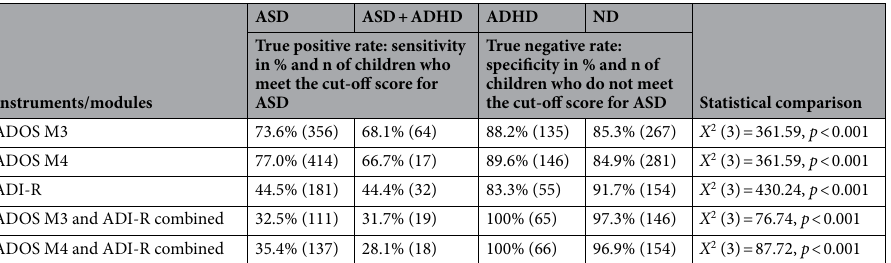
Table 1. Distribution of individuals per group that met total cut-off scores for ASD on the ADOS and/or ADI-R. The table depicts the obtained true positive rates as well as the true negative rates of the four groups with respect to the Autism Diagnostic Observation Schedule (ADOS), the Autism Diagnostic Interview- Revised (ADI-R), and both instruments combined. ASD autism spectrum disorder, ADHD attention-deficit/ hyperactivity disorder, ND no psychiatric